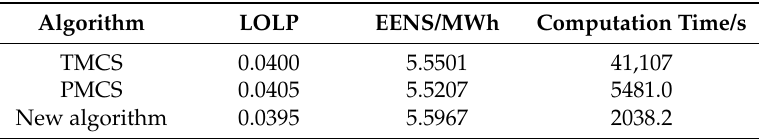
Table 2. Comparison of indices with different